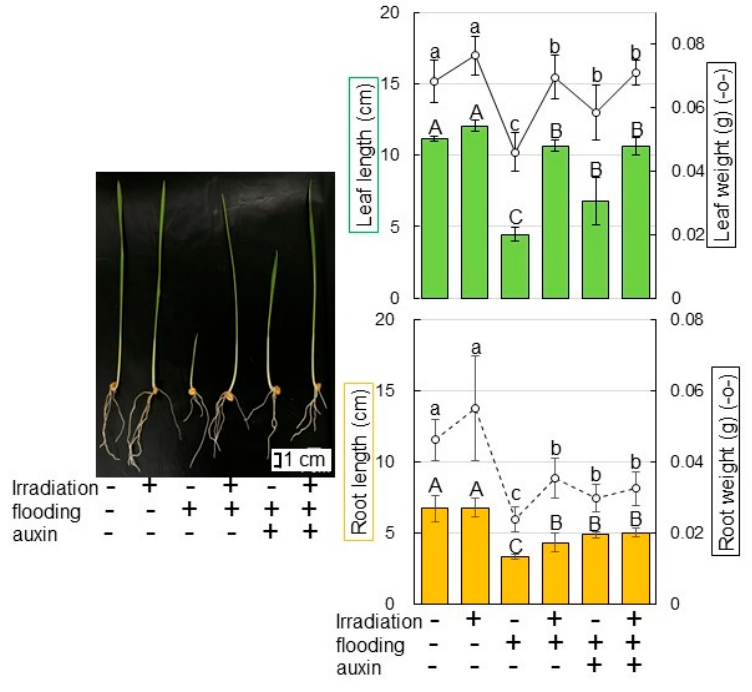
Figure 8. Morphological effect of auxin application on wheat under flooding stress. For the non- flooded group, samples were collected at 6 days after sowing. For flooded group, 3-day-old wheat seedlings were treated with 3-day flooding and samples were collected. For auxin treated group, 3-day-old wheat seedlings were treated with auxin under flooding stress for 3 days and samples were collected. Leaf length (green column), leaf-fresh weight (black solid line graph), main-root length (orange column), and total-root weight (black dotted line graph) were measured as morphological parameters. Bar indicates 1 cm. The data are given as the mean ± SD from three independent biological replicates. The statistical analysis is same as Figure 4.